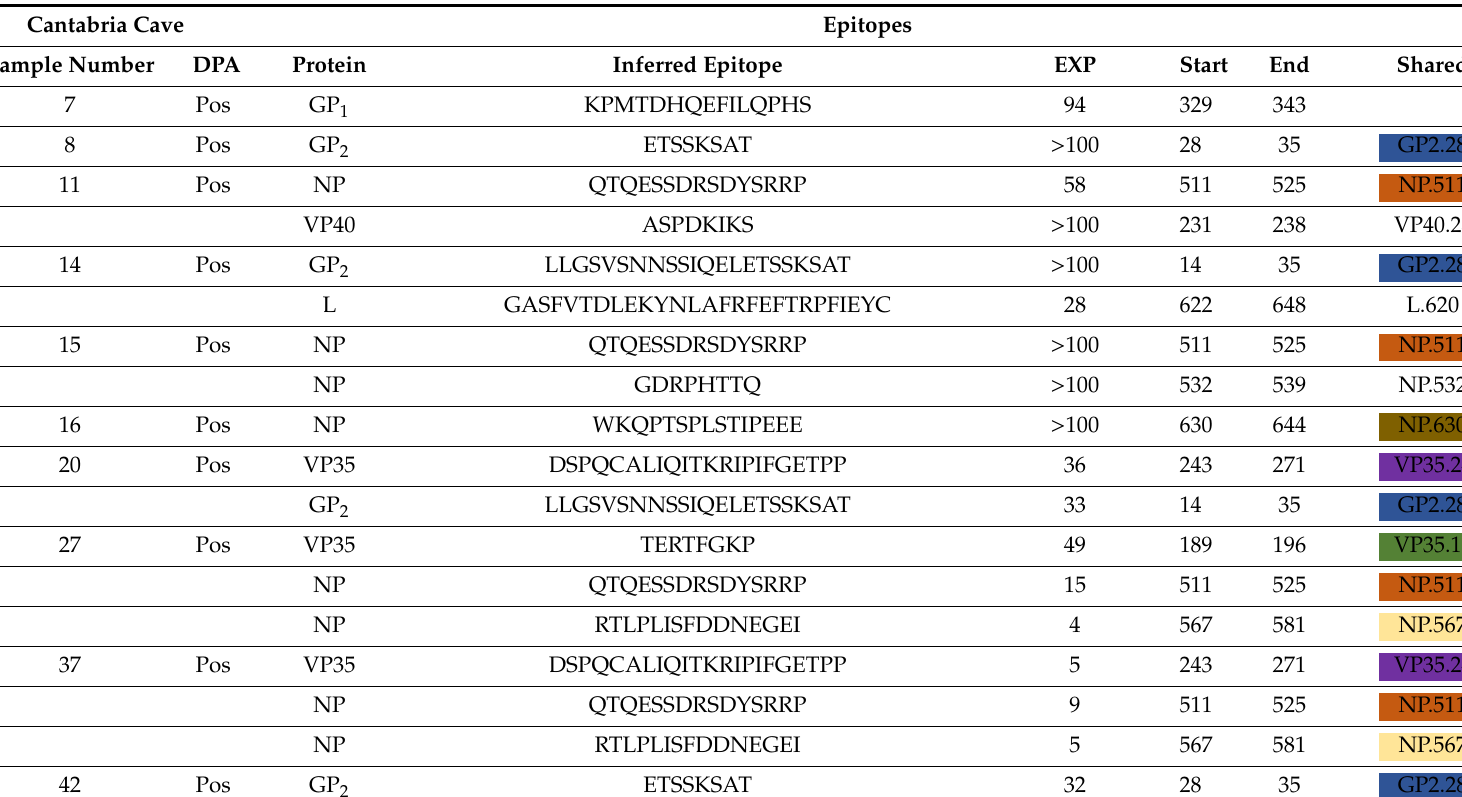
Table 2. Inferred epitopes detected by Domain Programmable Arrays (DPA) in the Schreiber’s Bent-winged bats samples with evidence of Lloviu (LLOV) exposure. Epitopes are described based on the protein they belong to, amino acid sequence, enrichment value (EXP), position of the first and last amino acid in the sequence (Start and End), and epitopes found in more than one animal